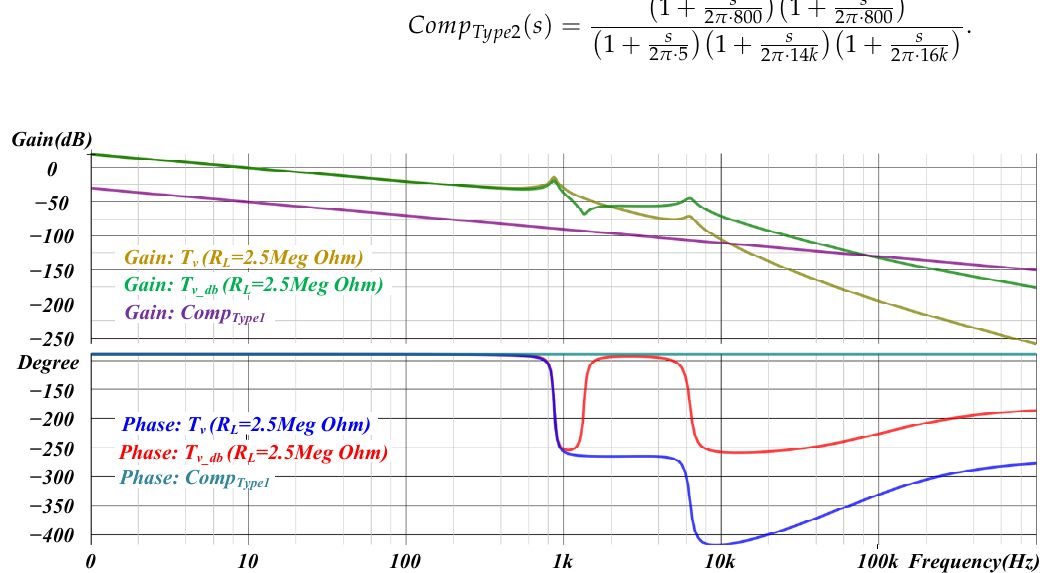
Figure 24. Bode plot of the closed-loop transfer function using the first compensator. As the boundary control mode will eventually return to the ordinary operation mode, and G dv is used as the basis for the final system stability, the second type of compensator design concept aims to design only for G dv and disregard the stability of G dv_bd . The design parameters of the second type of compensator are shown in Equation (56). Figure 25 shows the closed-loop gain using the second type of compensator, where T v = G dv C ompType2 and T v_db = G dv_bd C ompType2 . Note that only the closed-loop gain of G dv is stable, while the closed-loop gain of G dv_bd has insufficient GM and PM in two places. Although the closed- loop bandwidth of G dv is increased, the system has unstable factors in the boundary limit control mode.